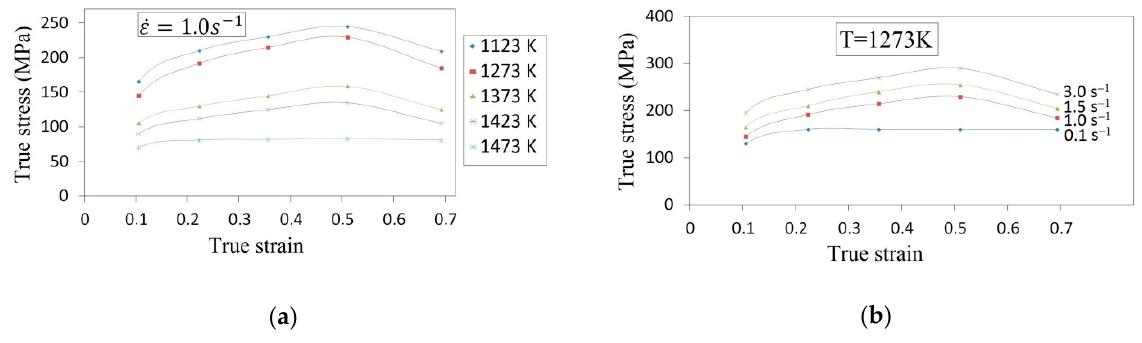
Figure 1. Flow curve plots for specimens deformed at ( a ) constant strain rate of 1.0 s − 1 and different deformation temperatures and at ( b ) different strain rates and a constant temperature of 1273 K.